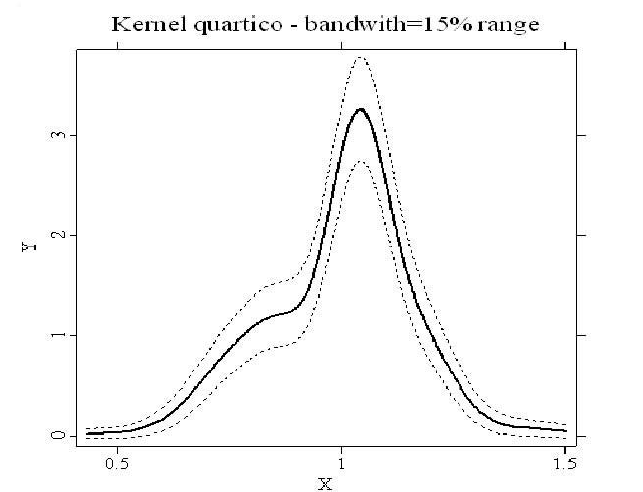
Figura 3 – Distribuzione condizionata allo sviluppo strutturale